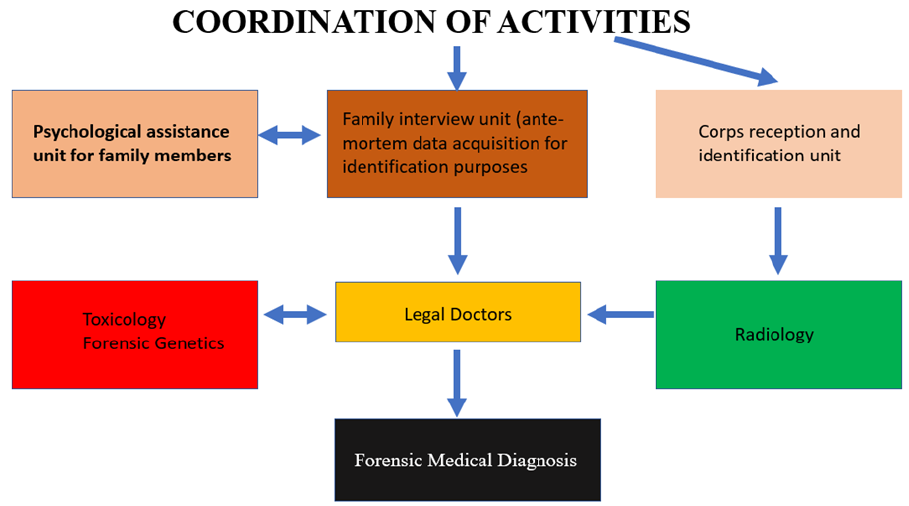
Figure 1. Flow-chart of actions to be taken in the course of a mass disaster.